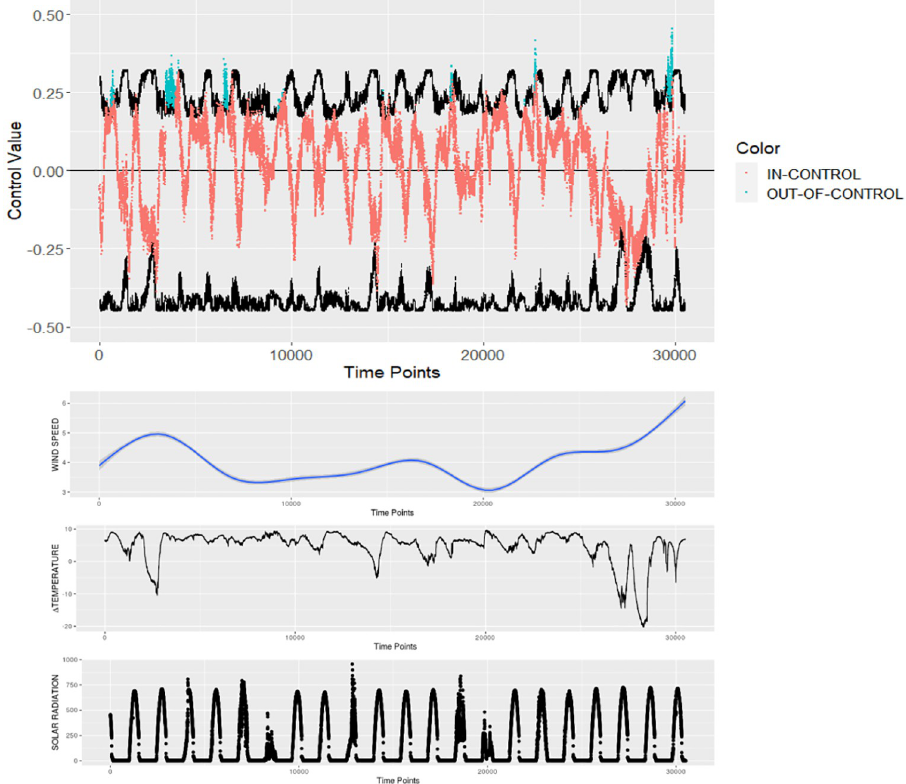
Fig 9. UL regression control chart (Phase II) adopting the residual representation (top panel), and the covariates’ dynamic plots (lower panels).